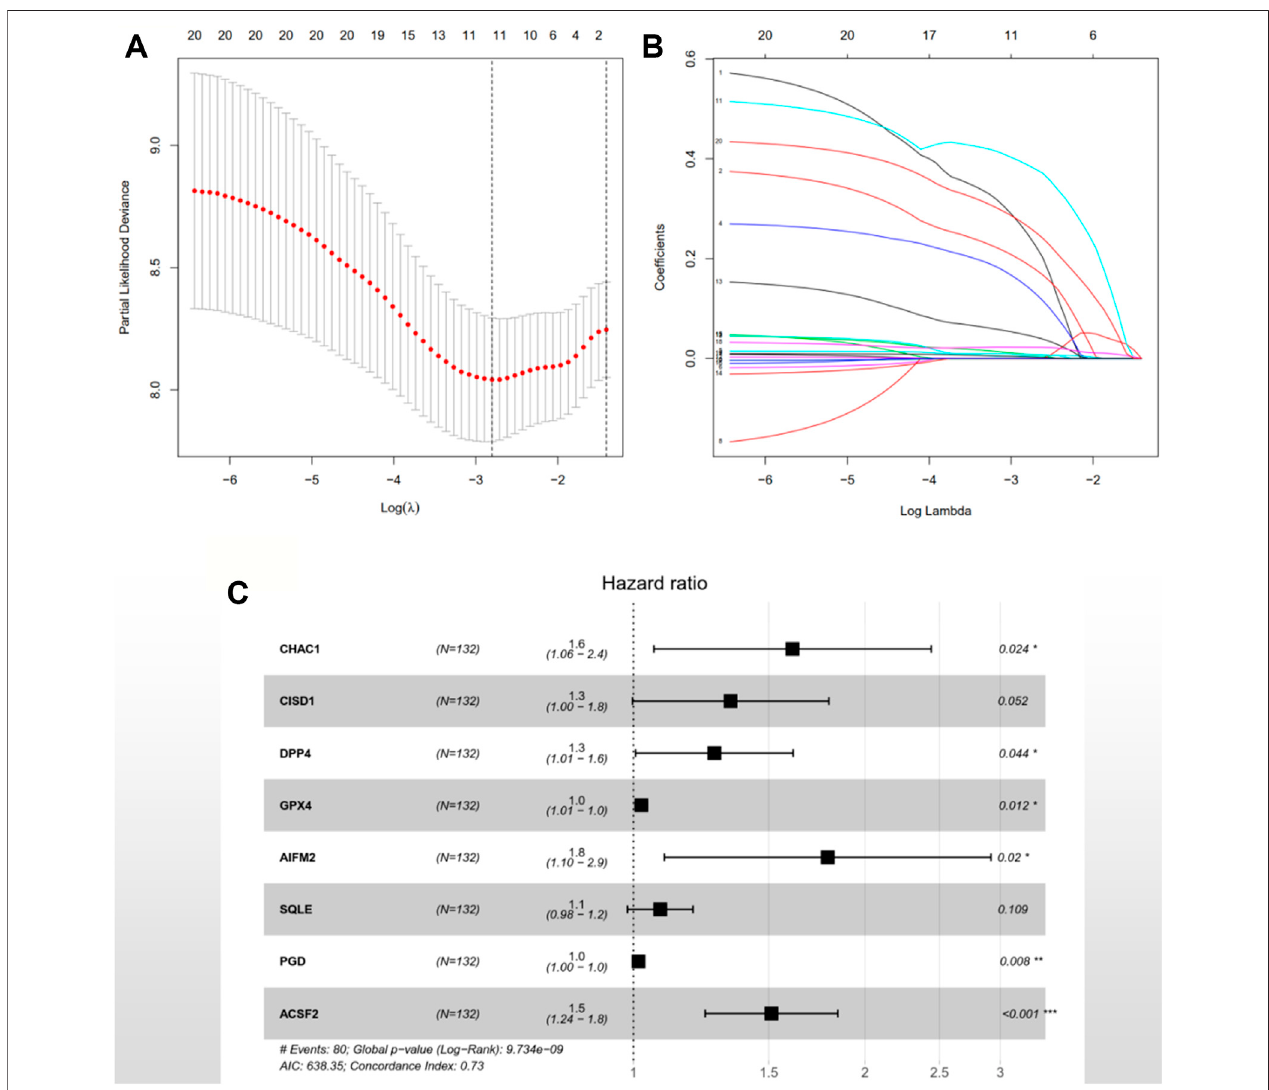
FIGURE1| Aneight-geneprognosticsignaturewasconstructedbasedontheLASSOalgorithminthetraininggroupTCGA-LAML. (A) 1,000-foldcross-validation was performed to choose the lambda value with the minimum cross-validation error. (B) The coef fi cients of model genes were calculated to remove highly correlated genes. (C) A forest map of the eight featured genes. HR > 1 indicates the gene is a high-risk gene; otherwise, the gene is a low-risk factor. p < 0.05 illustrates the independence of the gene for predicting the prognosis of AML patients, and vice versa. TCGA: The Cancer Genome Atlas; AML: acute myeloid leukemia; LASSO: least absolute shrinkage and selection operator; HR: hazard ratio.